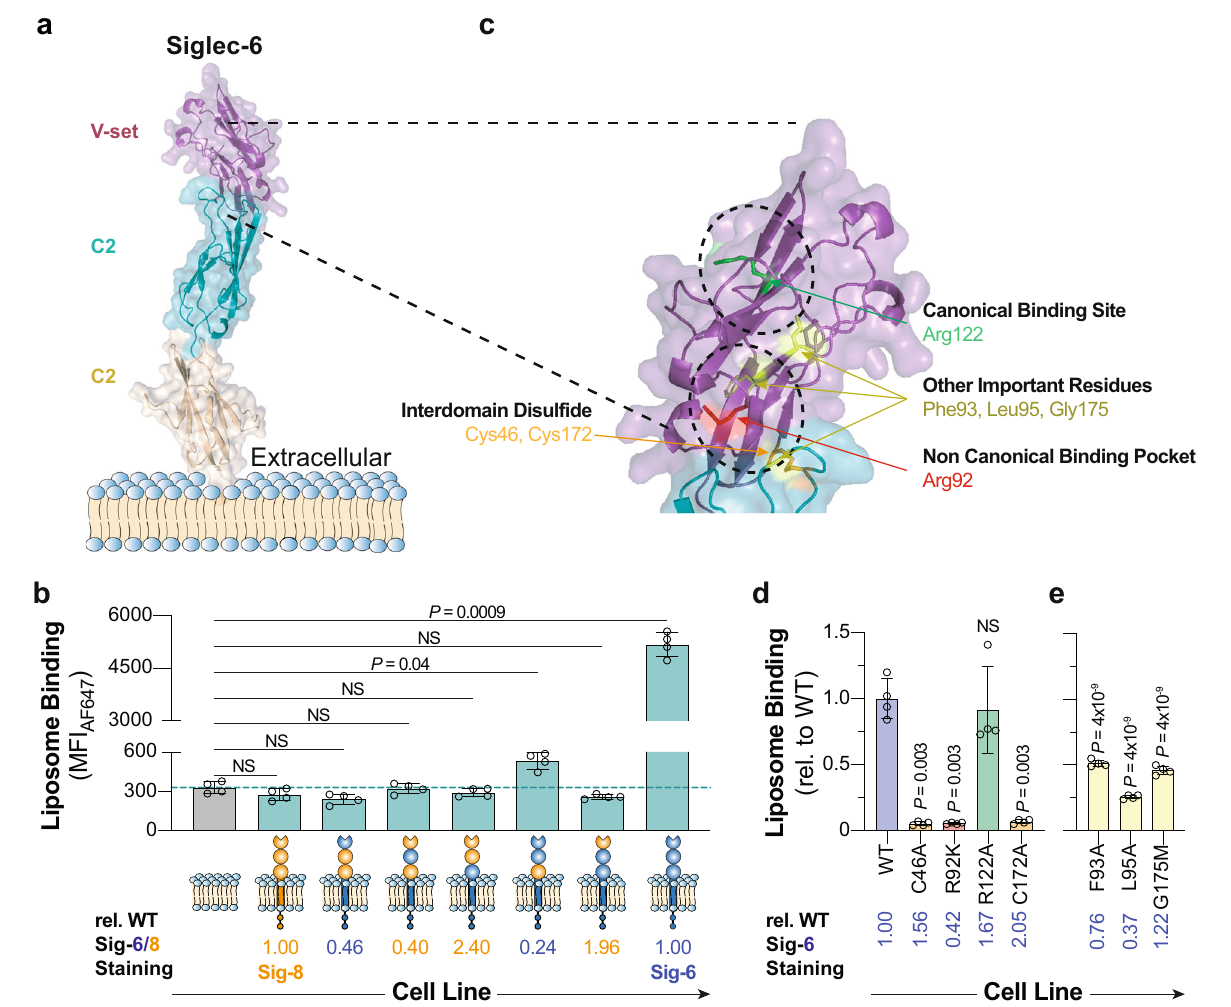
Fig. 4 | Identifying the location of the noncanonical glycolipid binding pocket in Siglec-6. a AlphaFold-generated molecular model of Siglec-6 extracellular domains. b Binding of 5 nGLLs to CHO cells expressing each Siglec-6/8 chimera. The dotted line represents the average binding of 5 nGLLs to UT CHO cells ( n =4 technicalreplicates).RelativeSiglecstainingisde fi nedbytheamountofanti-Siglec staining of the chimeric cell line over the anti-Siglec staining of the WT cell line. c ExpansionofthemolecularmodelofSiglec-6attheinterfaceoftheV-setdomain and the fi rst C2 domain, with residues of interest highlighted as sticks (green,